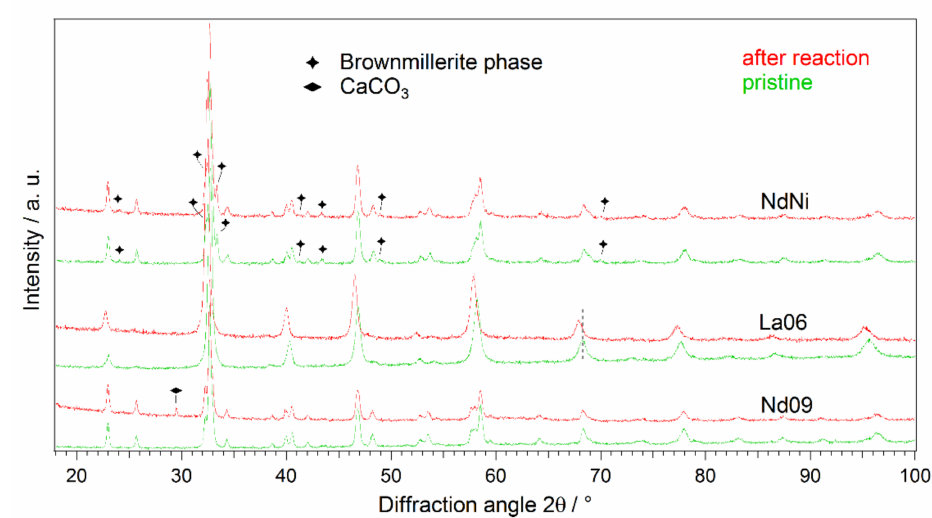
Figure 8. Comparison of XRD patterns of Nd09, La06, and NdNi before (green tracks) and after (red tracks) CO oxidation. Stars denote reflexes of the impurity phase Brownmillerite, the diamond marks a reflex associated with CaCO 3 . Nd09 exhibits small amounts of CaCO 3 after the reaction, while both La06 and NdNi do not show any new phases after the reaction. However, the reflexes of La06 are shifted to lower angles. No significant changes in the diffractogram of NdNi were found after CO